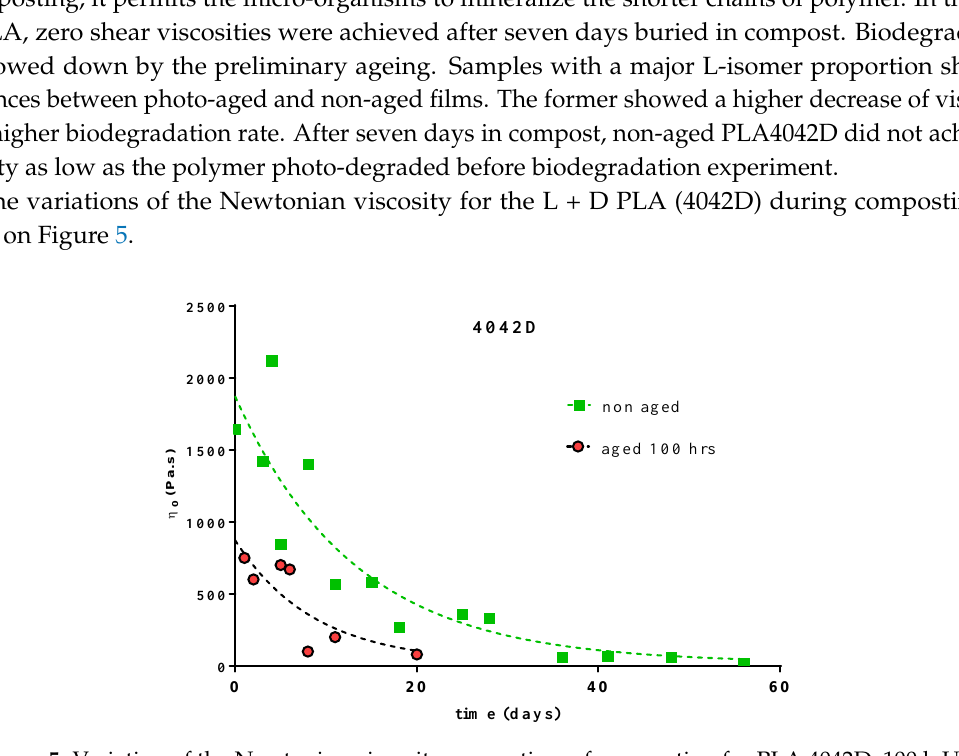
Figure 4. Cole–Cole plots of PLLA, PDLA and PLA4042D non-aged and photo-aged during composting (0 until to 7 days). Unfilled symbols: after 100 h of photo-ageing; filled symbols non-aged. Viscoelastic experiments have been performed at T = 180 °C.